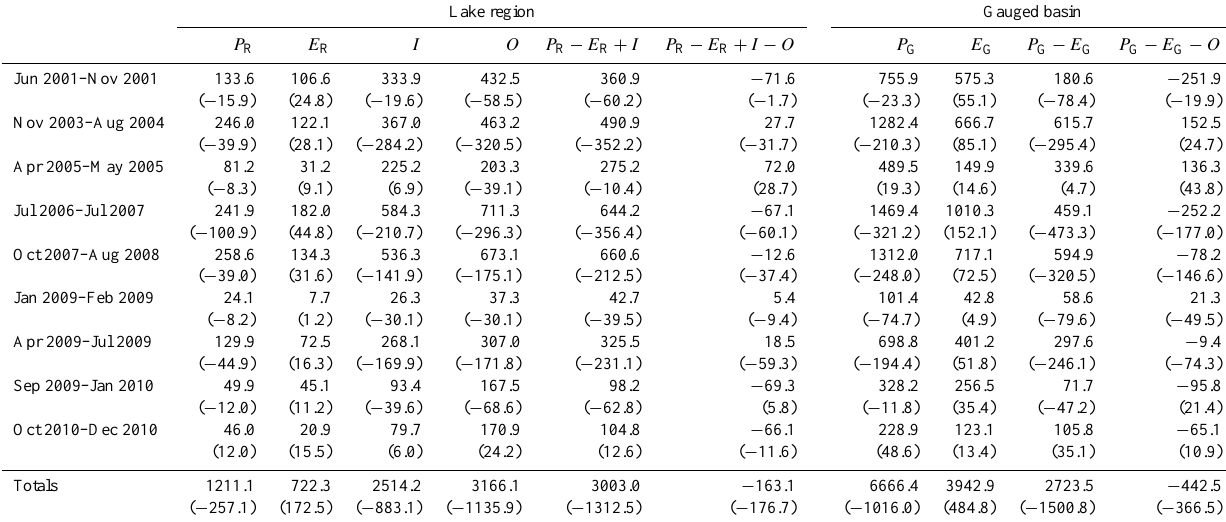
Table 2. Water components (unit in mm) of the Poyang Lake region and of the gauged basin for the drought periods. The values in parenthesis are the anomaly of a component against the multi-year mean in 1961–2010. All the water amounts are normalized to equivalent water height of the whole Poyang Lake